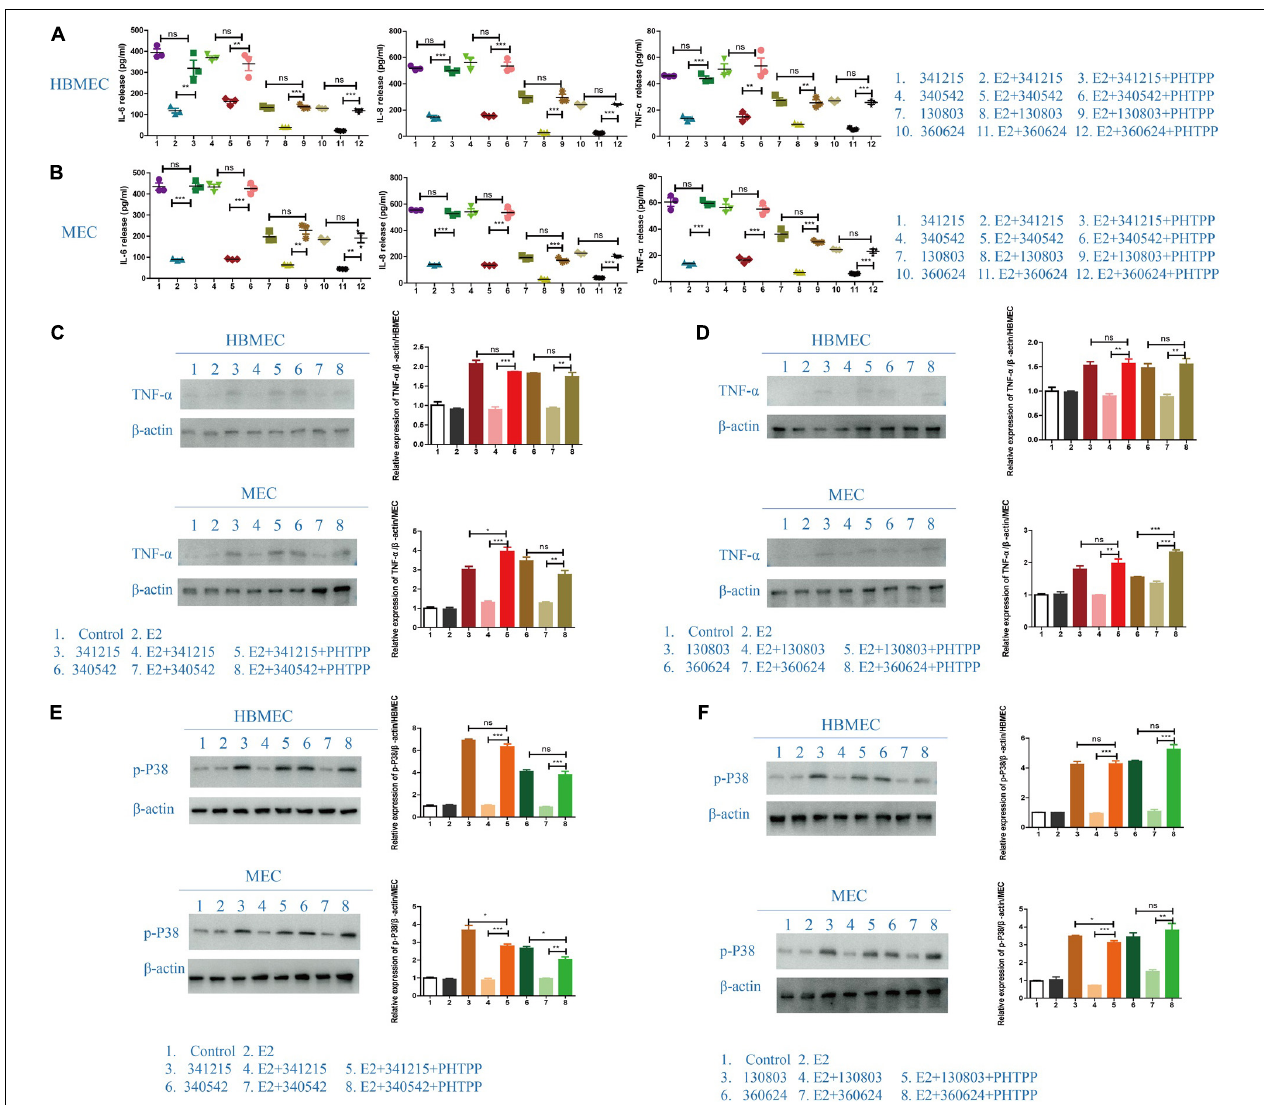
FIGURE 6 | The effect of ER β on the role of E2 in Neisseria meningitidis -infected cells. (A,B) HBMECs (A) and MECs (B) were divided into three experimental groups: N. meningitidis infection group, E2- N. meningitidis co-stimulation group, and PHTPP-E2- N. meningitidis co-stimulation group. The supernatant was extracted and the levels of IL-6, IL-8, and TNF- α in the supernatant was detected using ELISA assays. (C–F) HBMECs and MECs were treated as shown. Cells (CTR) without any treatment and the cells treated with E2 were used as controls, and proteins were extracted for western blotting. The levels of TNF- α and p-p38 were detected and β -actin was used as the internal control. The changes in protein levels were analyzed as above. * P < 0.05, ** P < 0.01, *** P <